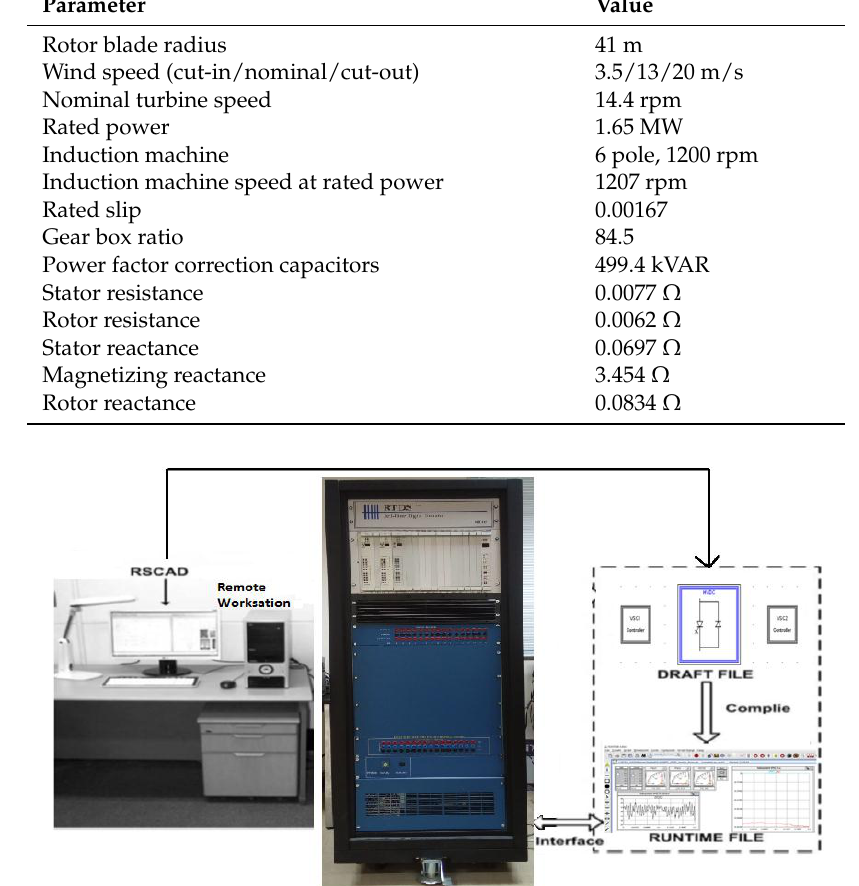
Figure 4. Real Time Digital Simulator setup.